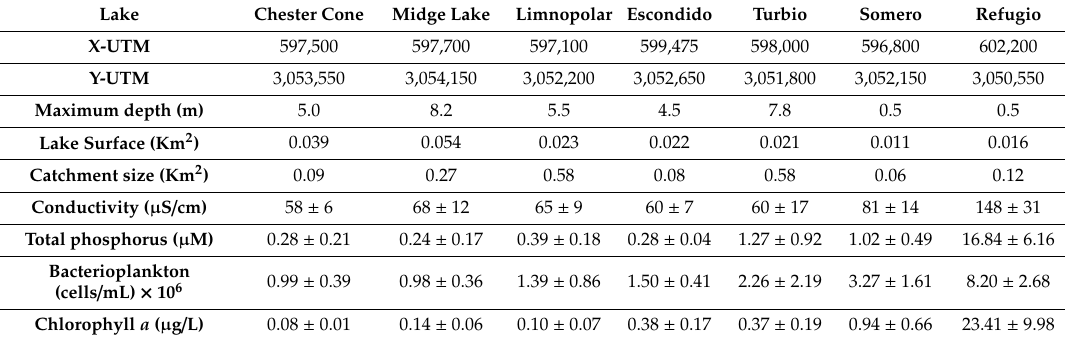
Table 1. Main limnological characteristics and average ± standard deviation of some variables of representative lakes from Byers Peninsula. Average values represent data compiled from surveys conducted in these lakes during di ff erent austral summers, from 2001 / 2002 to 2008 / 2009. The Universal Transverse Mercator (UTM) coordinates format is the World Geodetic System 1984 (WGS-84), from the International Map of the World (IMW) sheet numbering